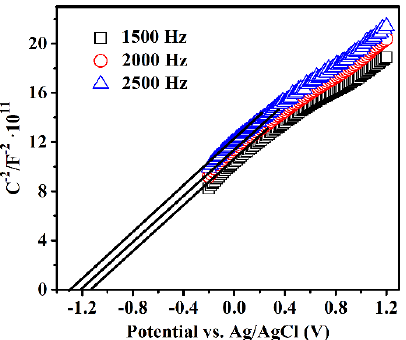
Figure 5. Mott – Schottky plots of S 850 . Electrolyte: 0.2 M Na 2 SO 4 . The different AC frequencies were used for the measurements: 1500, 2000, and 2500 Hz. Tangent lines of the Mott – Schottky plots were drawn to obtain the flat band potential.